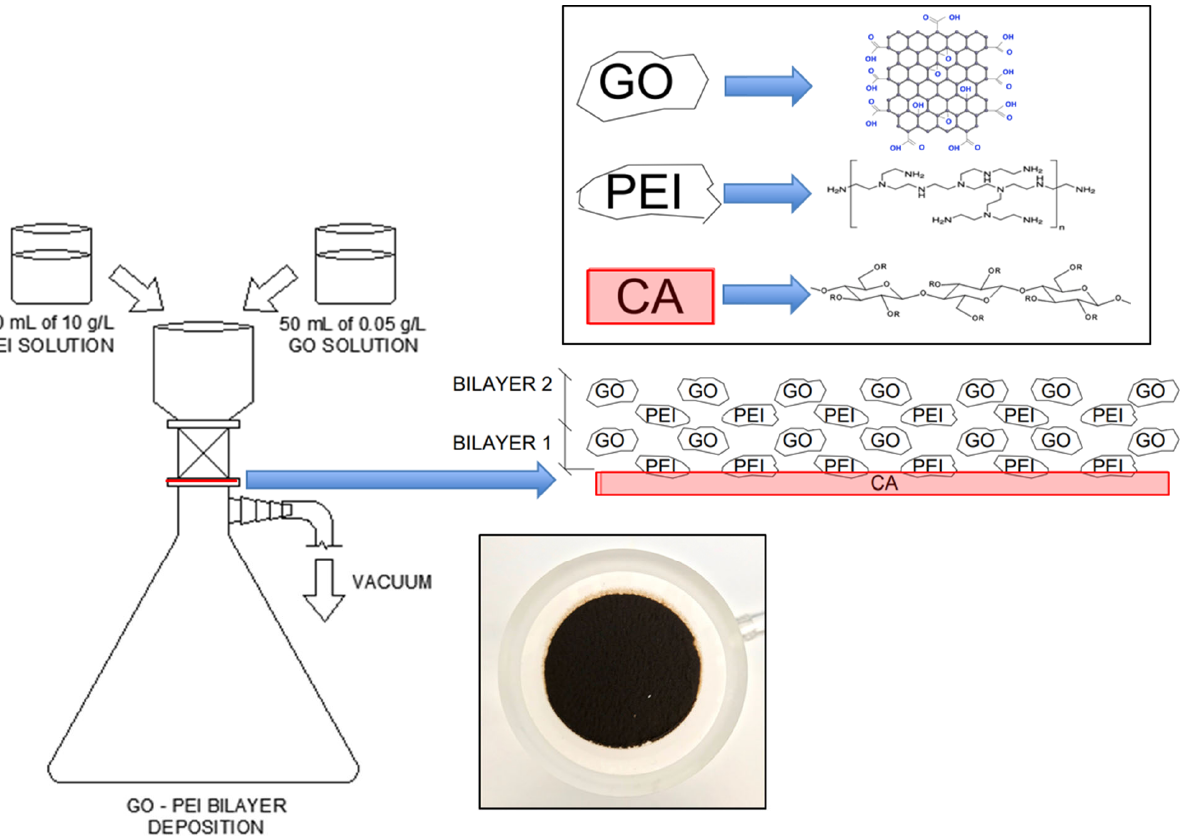
Figure 1. Cellulose acetate membrane modification process using graphene oxide–polyethyleneimine for dye/salt mixture solution.